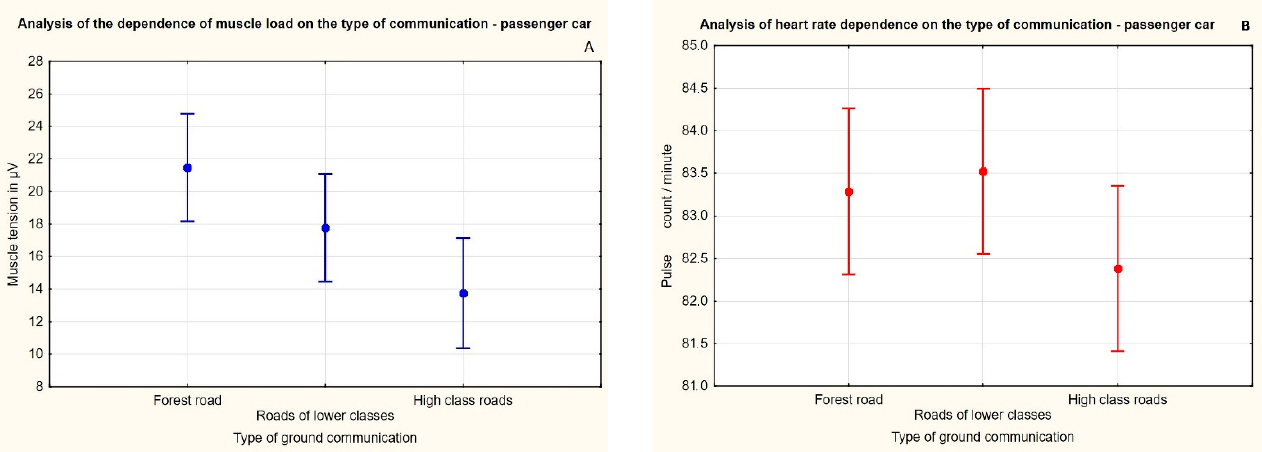
12 of 17 Table 10. Post hoc test to analyze the variance of heart rate values depending on the type of com- munication when driving the passenger car. Scheffe’s Test; Pulse Variable Probabilities for Post hoc Tests Error: Intermediate. SS = 4.9746, AS = 60.000